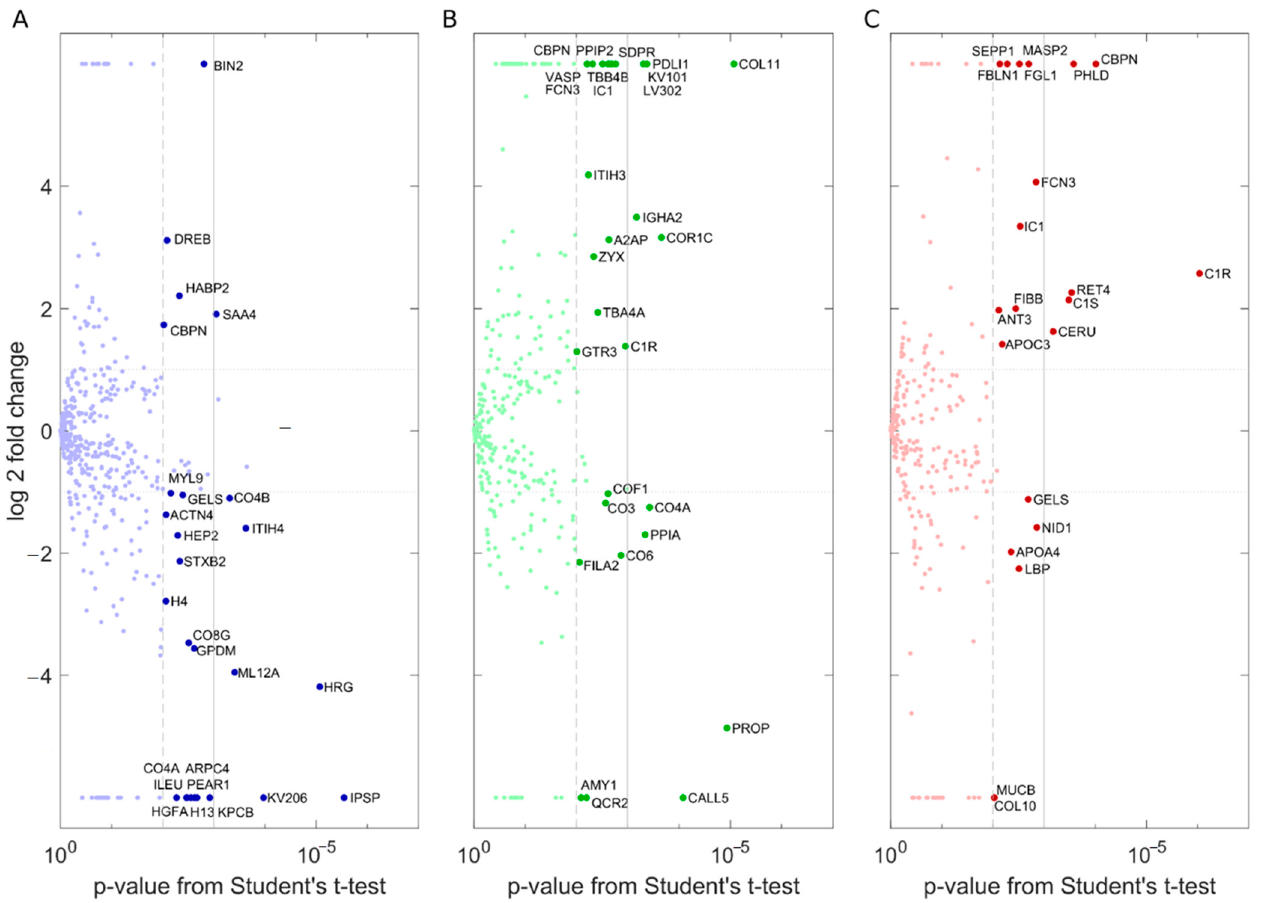
Figure 4. Volcano plots depicting corona proteins, whose RPAs are significantly different between healthy and PDAC samples, in terms of fold-changes and p -values from Student’s t-test, for ( A ) L 1 , ( B ) L 2 and ( C ) L 3 .